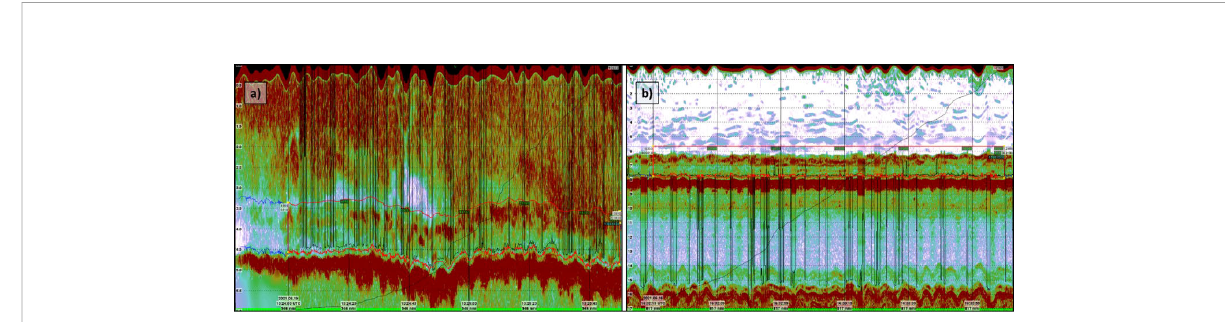
FIGURE 5 Examples of settings where the bottom detection fails. The black lines show the result of the bottom detection in the pre-processor KORONA, the lower red line is the manually set lower integration line. (A) Echogram from Helgeland station 4 where shallow air bubbles cause the algorithm to fl uctuate between the actual seabed and the near fi eld. (B) Echogram from Vikna station 391 where the algorithm fl uctuates between the actual seabed and the 2nd